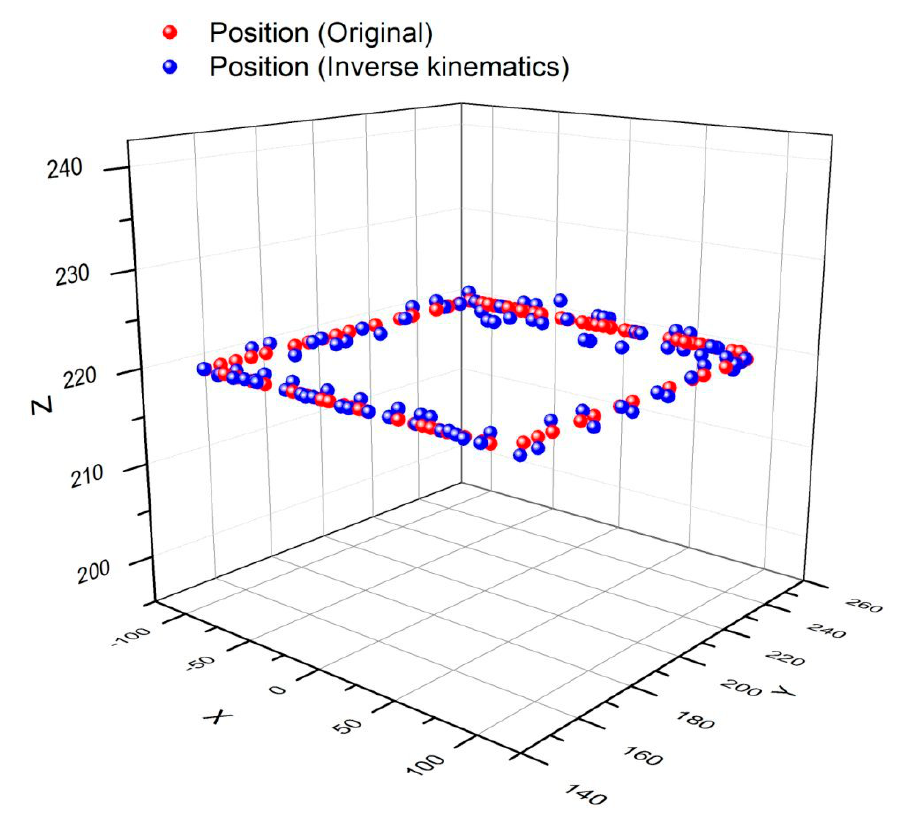
Figure 6. Theoretical and measured paths for a robot arm moving along a rectangular path without a payload.